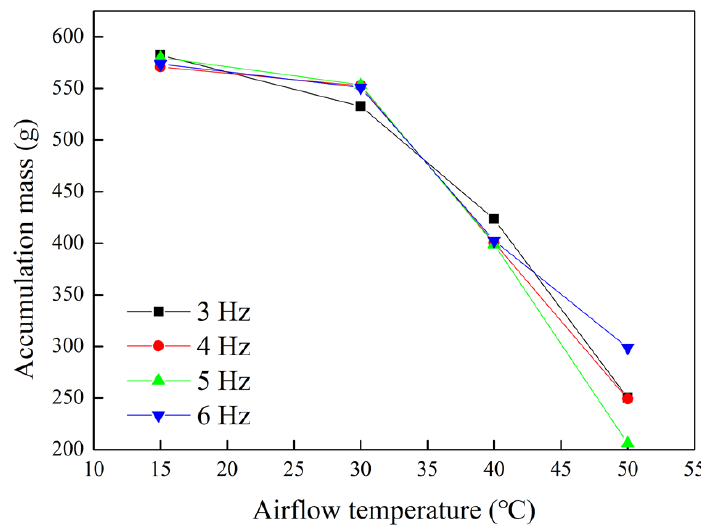
Figure 11. Effect of airflow temperature on accumulation